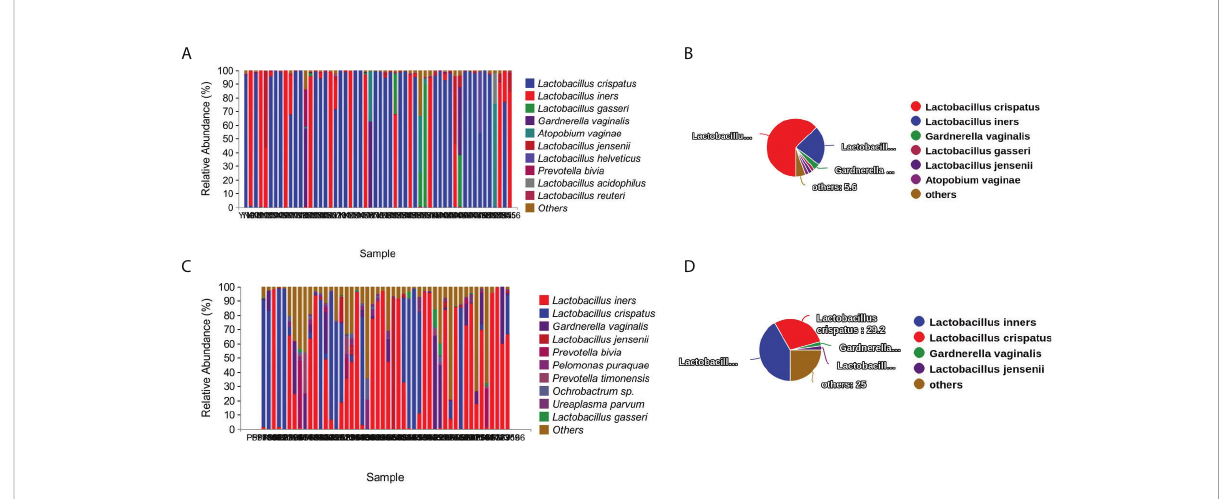
FIGURE 1 Vaginal microbiota composition and percentage of dominant taxa at species level. (A) Vaginal microbiota composition in the term delivery group at the species level. (B) Percentage of dominant species in the term delivery group. (C) Vaginal microbiota composition in the PPROM group at the species level. (D) Percentage of dominant species in the PPROM